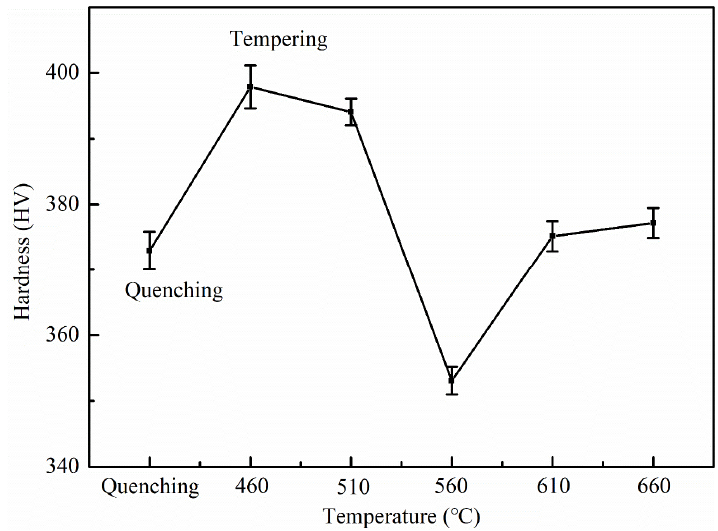
Figure 3. Hardness changes of Fe-9Ni-2Cu steel with the increase of temperatures.